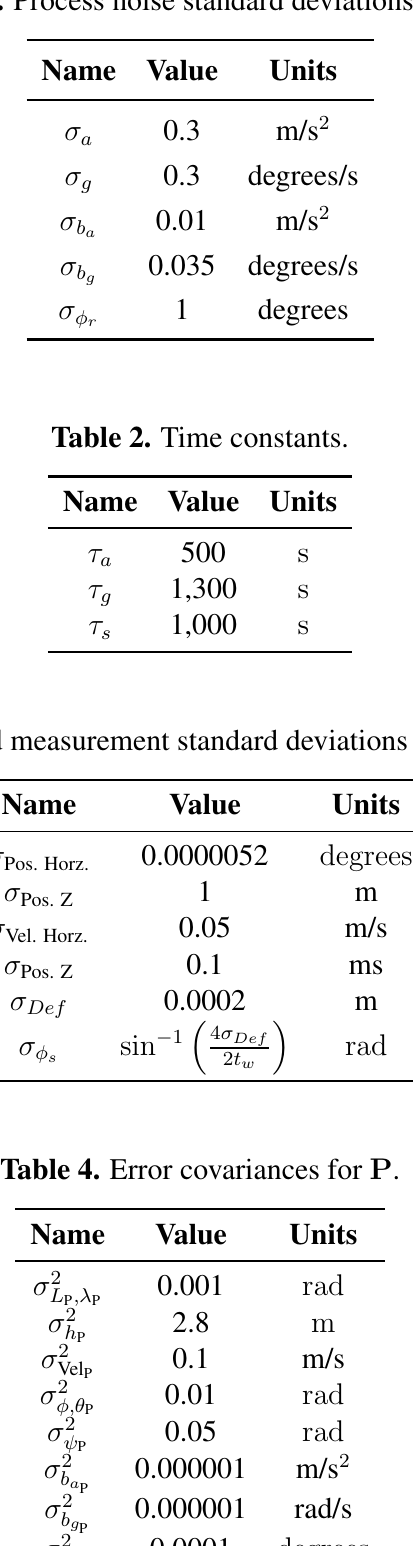
Table 1. Process noise standard deviations for Q .